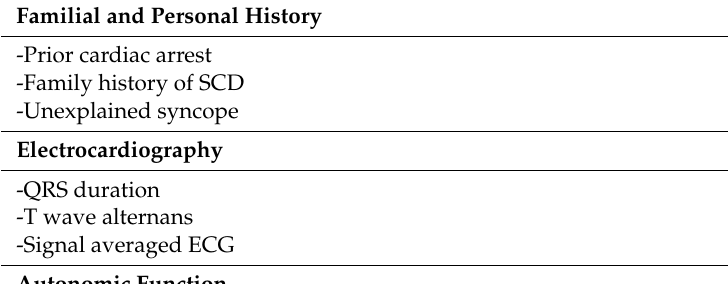
Table 1. Risk factor for SCD in